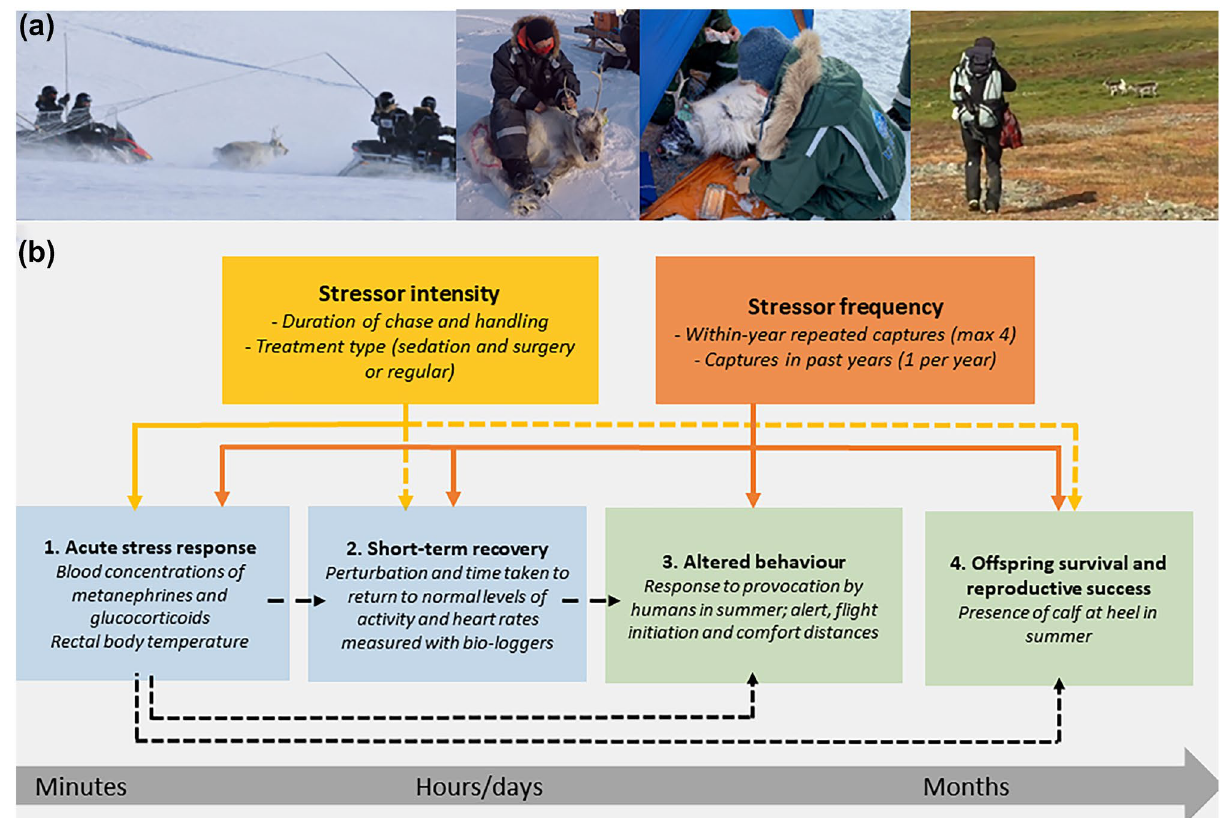
Figure 1. Conceptual figure of the study. Panel ( a ) shows photos from field work, all taken by Erik Ropstad. From left to right: capture of reindeer using a net held between two snowmobiles; manual restraint of reindeer; surgery performed on sedated reindeer; provocation of reindeer by approaching observer. Panel ( b ) provides an overview of the study and data collected. The first row of boxes indicate which type of potential stressors were evaluated, while the second row summarises the responses measured in winter (blue) and in summer (green). Arrows indicate which relationships were tested, with solid and dashed lines indicating significant and non- significant results,